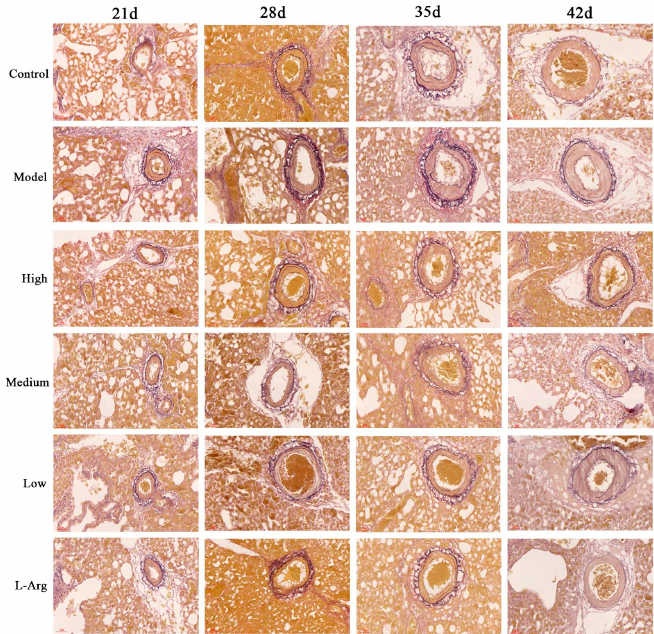
Figure 4. The effect of QLJP on the pathological changes of pulmonary arterioles by Weigert-Van Gieson staining (400×, scale bar = 20 μ m). Control is the control group, Model is the model group, High is the high dose group of QLJP, Medium is the medium dose group of QLJP, Low is the low dose groupof QLJP, and L-Arg is the L-Arginine group. 3.5. The Effect of QLJP on Pulmonary Arteriole Remodeling The results of the analyses of the relative media thickness (%) and relative medial area (%) of pulmonary arterioles with diameters of 50–100 μ m are shown in Figure 5A,B. At each time point, the relative media thickness (%) and relative medial area (%) in the model group were obviously higher than the control group ( p < 0.01). Compared to the model group, the relative media thickness (%) and relative medial area (%) were reduced in the medium- and high-dose QLJP groups at each time point ( p < 0.05 or p < 0.01). The relative media thickness (%) at 35 d and the relative medial area (%) at 35 d and 42 d in the low-dose QLJP group were significantly decreased ( p < 0.05 or p < 0.01).